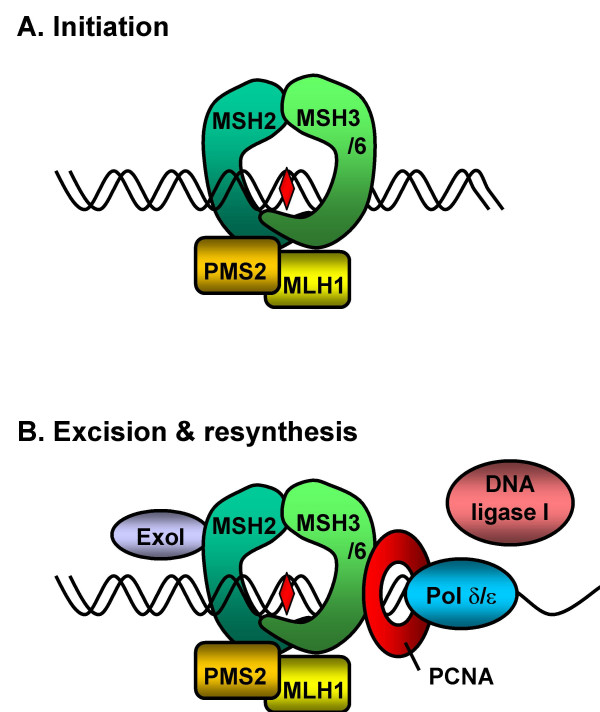
The mismatch repair system (MMR). A. Based on figure 3 from Bellacosa et al [8]. Initiation of MMR by recognizing the DNA damage by the MutSα or β complex and recruiting the MutLα complex. B. Excision of the damaged strand and resynthesis in which exonuclease ExoI, proliferating cell nuclear antigen (PCNA), DNA polymerase δ or ε and DNA helicase I are suggested to play a role.